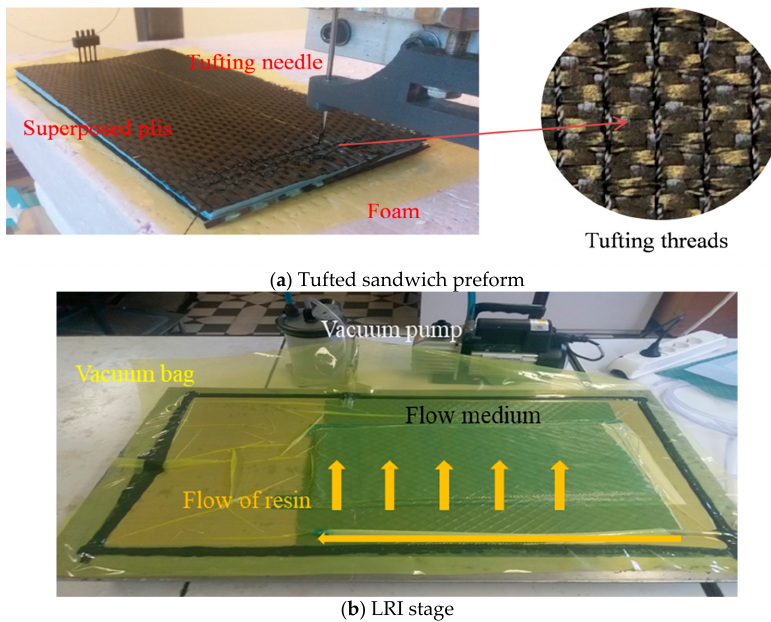
Figure 1. Manufacturing process of the sandwich composite. Table 1. Essential parameters of the samples.